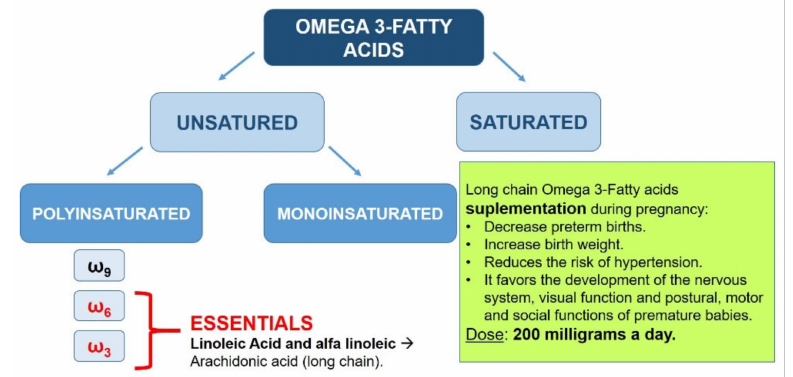
Figure 2. Importance of long-chain fatty acids during